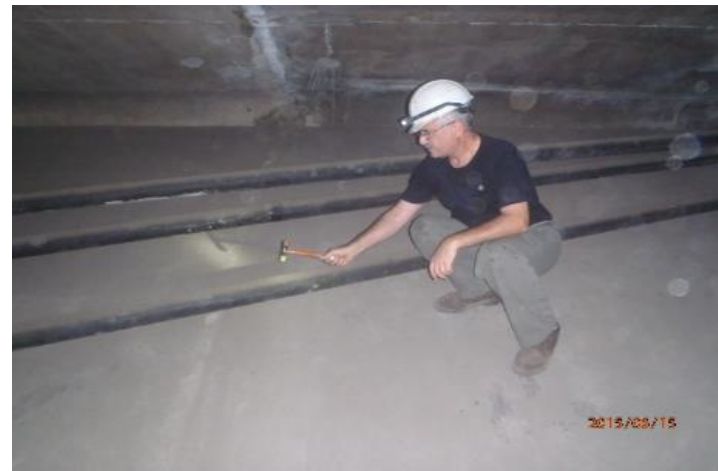
Figure 4. Sounding used for spot inspection.